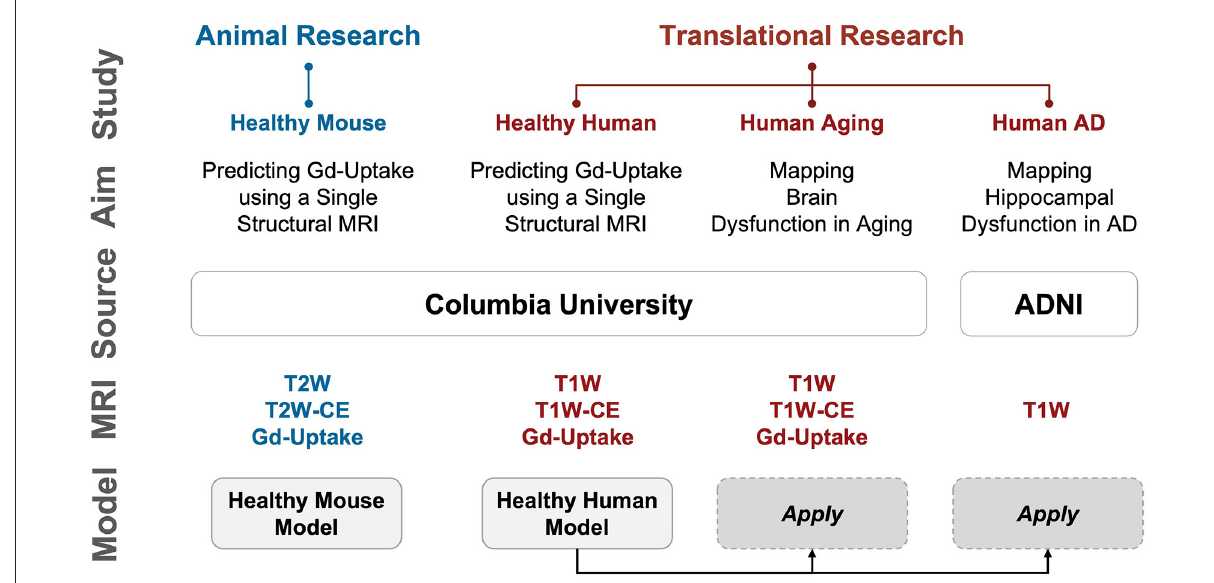
FIGURE1 Overview of the studies conducted. We first performed proof-of-concept studies in mice to validate our hypothesis that deep learning can extract information equivalent to Gadolinium-based contrast agent (GBCA) contrast enhancement from a single-modal non-contrast MRI scan, and then conducted extensive analyses in humans to scrutinize the capability of this proposed approach. Study: A study conducted; Aim: The purpose of the study; Source: where the imaging data come from; MRI: modality/type of data used in the study; Model: specific DeepContrast model used in the study. AD: Alzheimer’s disease; ADNI: Alzheimer’s Disease Neuroimaging Initiative dataset; CBV: cerebral blood volume; Gd-Uptake: GBCA contrast uptake maps; T2W: T2-weighted scans; T2W-CE: T2-weighted contrast-enhanced scans; T1W: T1-weighted scans; T1W-CE: T1-weighted contrast-enhanced